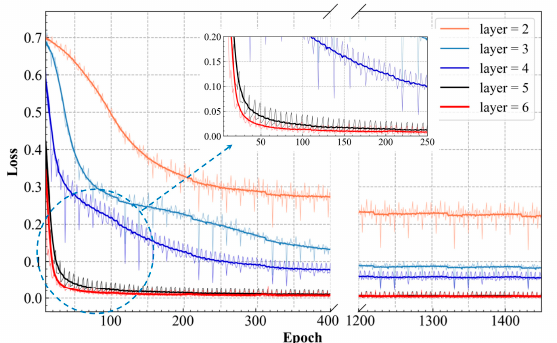
Figure 11. Convergence history of the network models with different numbers of network layers.